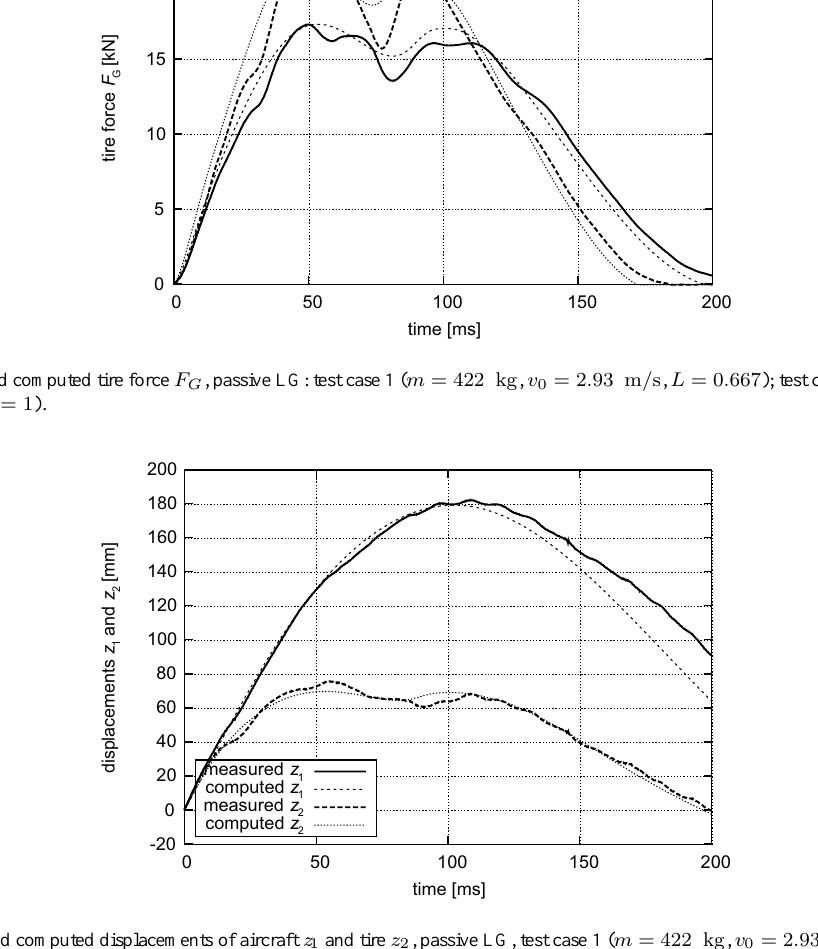
Fig. 4. Measured and computed displacements of aircraft z 1 and tire z 2 , passive LG, test case 1 ( m = 422 kg , v 0 = 2 . 93 m / s , L = 0 . 667